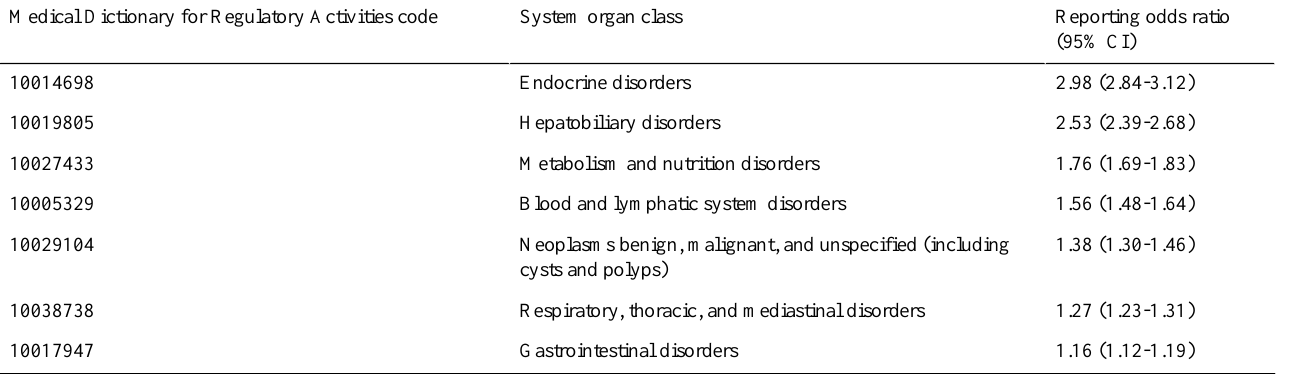
Table 4. The signal detection results at the system organ class